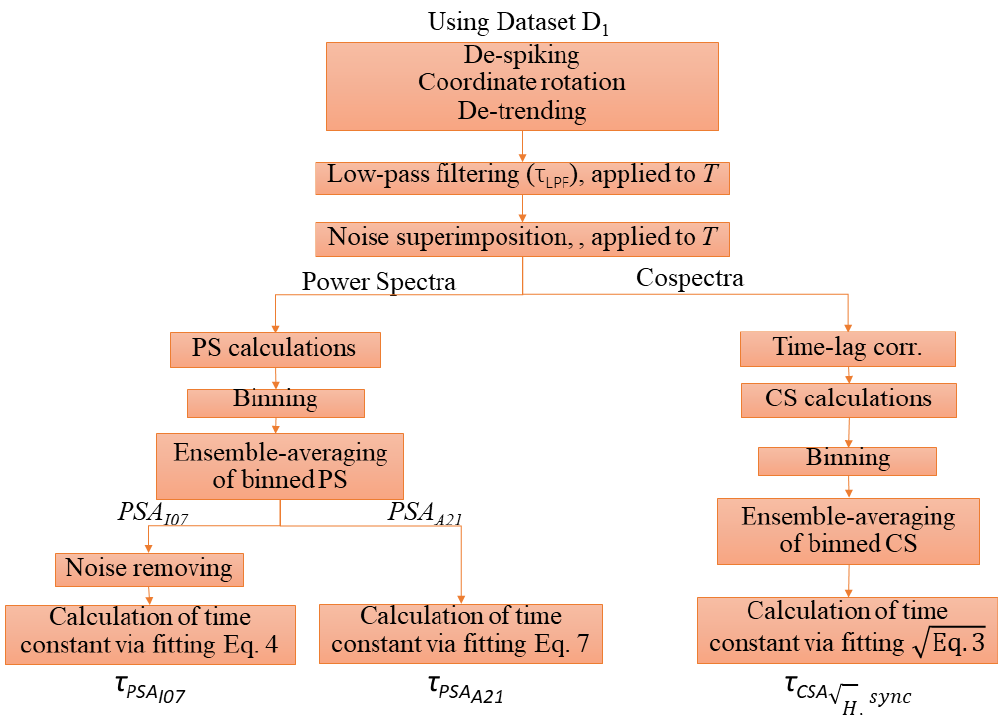
Figure 2. Flow chart of the data processing for time constant calculation using the dataset D 1 : τ LPF is the time constant of the first order filter, τ PSA and τ PSA represent the estimated time constants with power spectra (PSA) and τ CSA √ I07 A21 the spectral transfer